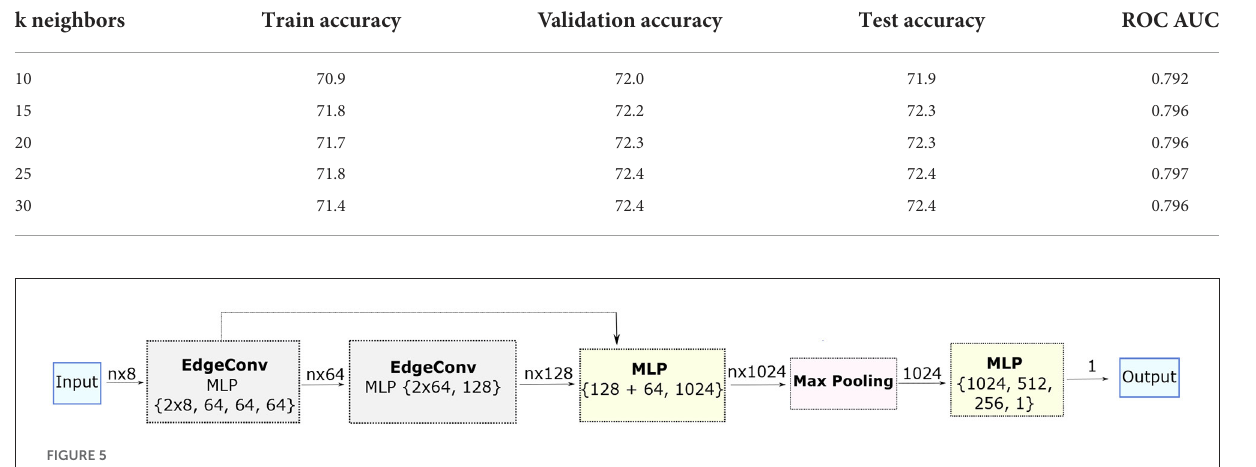
FIGURE5 Applied DGCNN architecture for neutron capture and electron background event discrimination. Two dynamic edge convolutional blocks were applied, followed by a fully connected layer, global max pooling, and a final multi-layer perceptron layer.